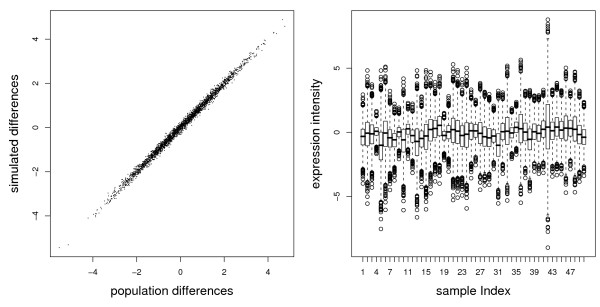
Characteristics of simulated data. The left plot shows the genewise population differences contrasted with the mean differences in simulated data. Population differences μiA
 MathType@MTEF@5@5@+=feaafiart1ev1aaatCvAUfKttLearuWrP9MDH5MBPbIqV92AaeXatLxBI9gBaebbnrfifHhDYfgasaacH8akY=wiFfYdH8Gipec8Eeeu0xXdbba9frFj0=OqFfea0dXdd9vqai=hGuQ8kuc9pgc9s8qqaq=dirpe0xb9q8qiLsFr0=vr0=vr0dc8meaabaqaciaacaGaaeqabaqabeGadaaakeaaiiGacqWF8oqBdaqhaaWcbaGaemyAaKgabaGaemyqaeeaaaaa@30FC@ - μiB
 MathType@MTEF@5@5@+=feaafiart1ev1aaatCvAUfKttLearuWrP9MDH5MBPbIqV92AaeXatLxBI9gBaebbnrfifHhDYfgasaacH8akY=wiFfYdH8Gipec8Eeeu0xXdbba9frFj0=OqFfea0dXdd9vqai=hGuQ8kuc9pgc9s8qqaq=dirpe0xb9q8qiLsFr0=vr0=vr0dc8meaabaqaciaacaGaaeqabaqabeGadaaakeaaiiGacqWF8oqBdaqhaaWcbaGaemyAaKgabaGaemOqaieaaaaa@30FE@ were set for each gene by randomly drawing from N(0,1). Simulated differences stem from drawing data from a multivariate distribution with these given population means. The right plot shows boxplots of all 3000 genes for all 50 samples of the simulated data for the training set (the test set is very similar and not shown).